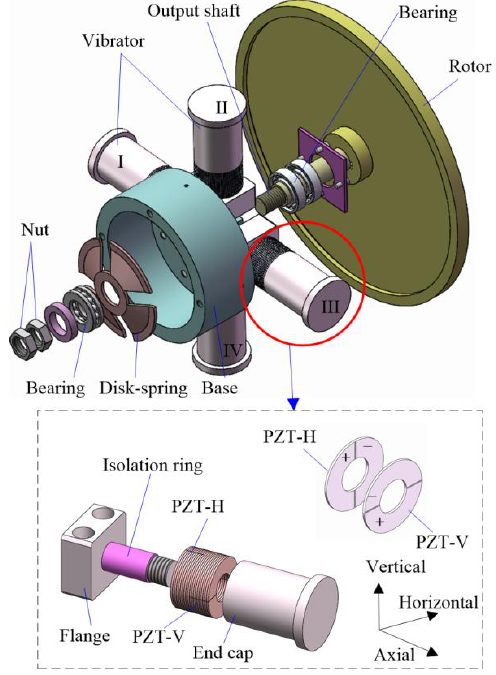
Figure 1. Three-dimensional structure of the piezoelectric actuator.